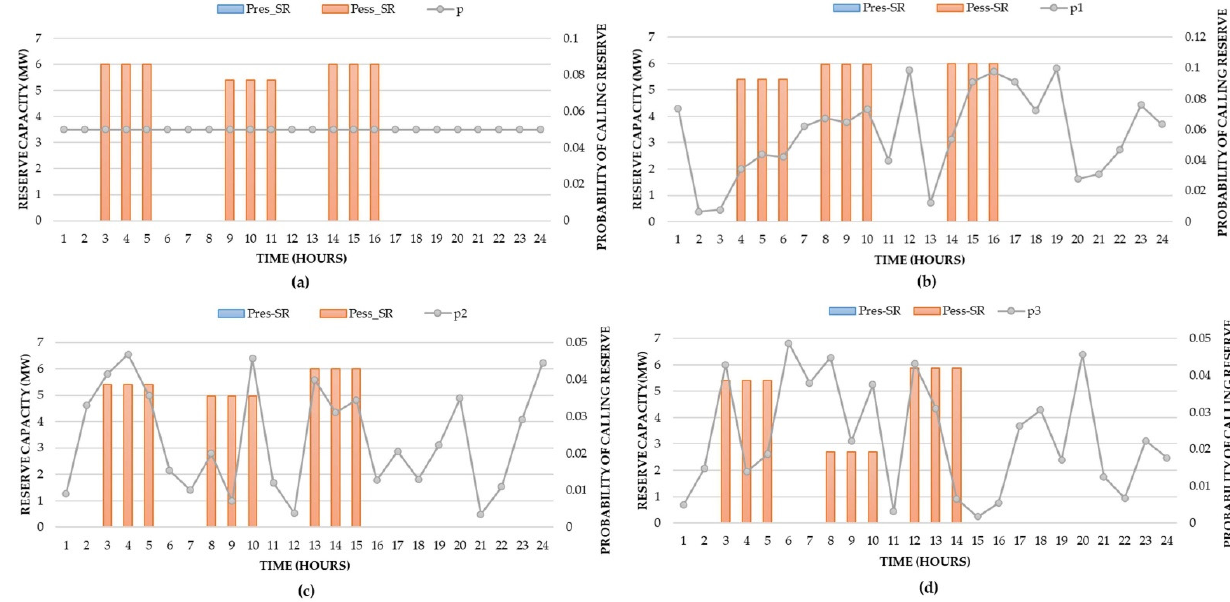
Figure 7. The VPP’s reserve bidding with ( a ) p = 0.05 for all hours, ( b ) scenario p 1 , ( c ) scenario p 2 , and ( d ) scenario p 3 of the reserve probability.